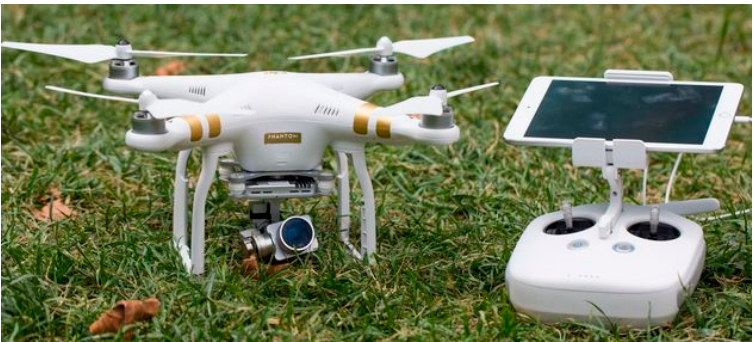
Figure 4. DJI Phantom 3 Professional